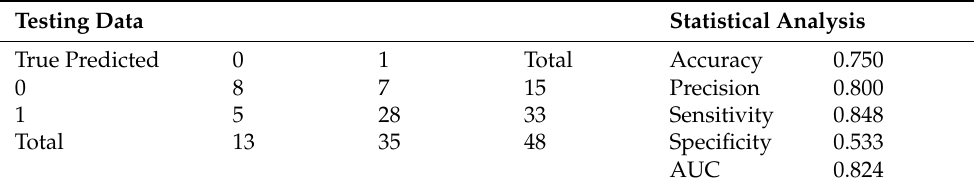
Table 2. Confusion matrix for the “Admission” Model.